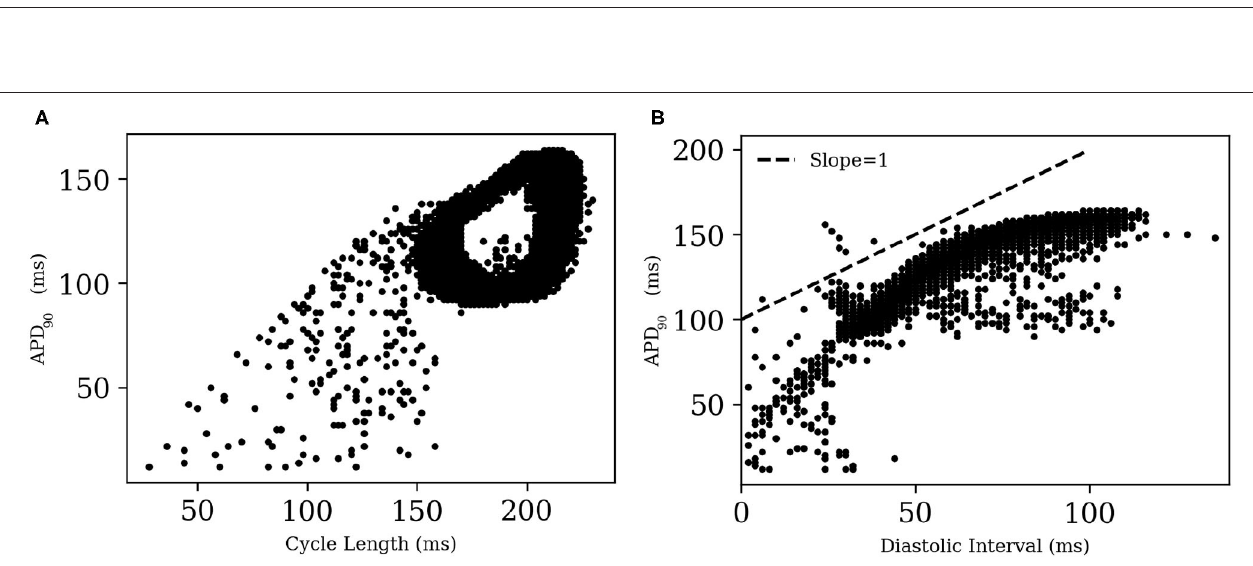
FIGURE 12 | Restitution curves for APD 90 in (A) a simulated spiral with respect to Cycle Length and (B) Diastolic Interval. The dashed line in (B) indicates the region of slope = 1.